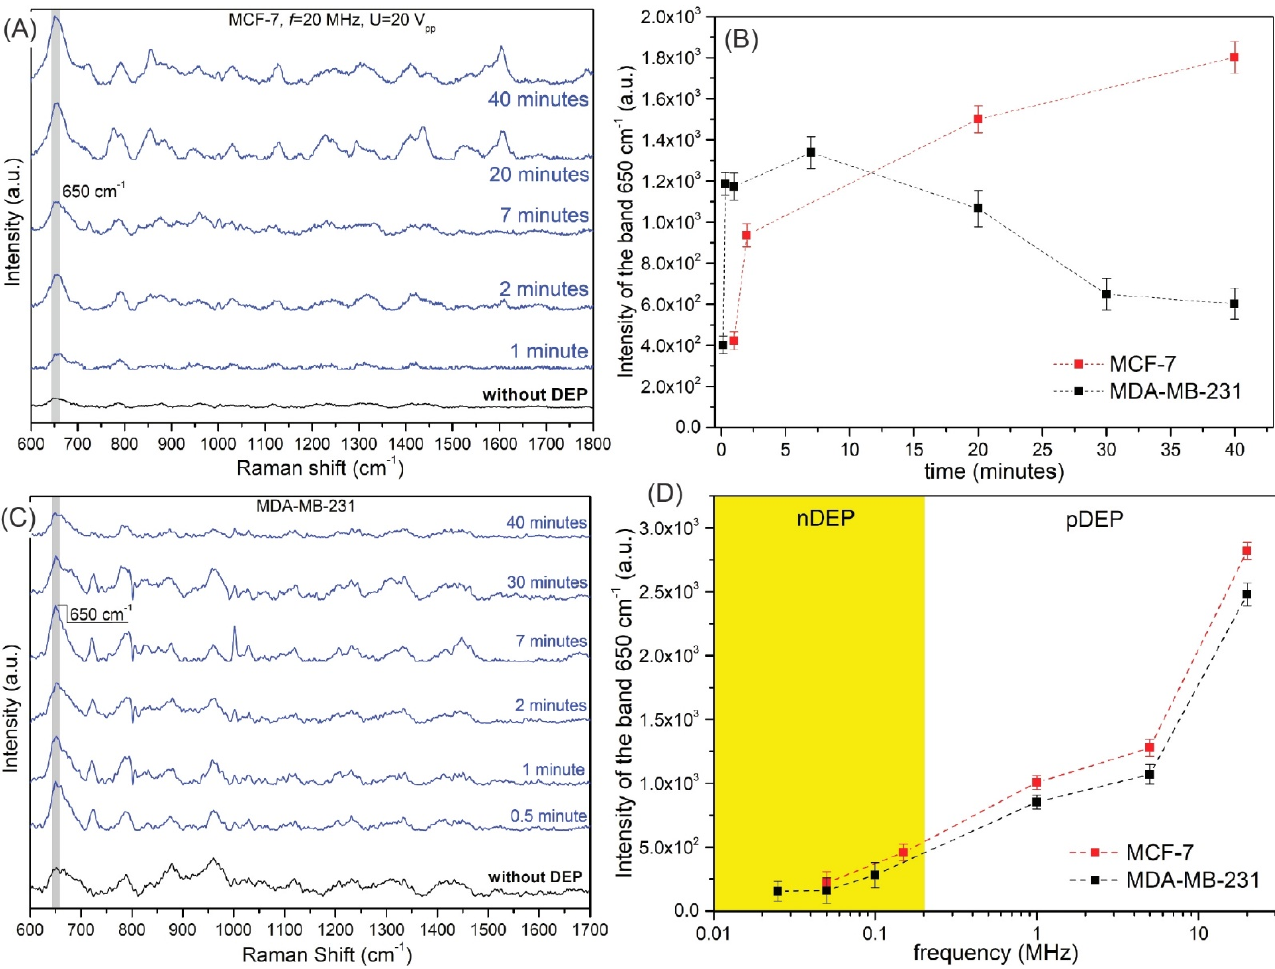
Figure 7. ( A ) The SERS spectra of the MCF − 7 cancer cells in the function of the deposition time via pDEP force for f = 20 MHz and U = 20 Vpp. ( B ) The averaged intensity of the band at 650 cm − 1 of the MCF − 7 ( f = 20 MHz, U = 20 Vpp) and MDA − MD − 231 ( f = 5 MHz, U = 20 Vpp) for different deposition times (0.5 min to 40 min). ( C ) The selected SERS spectra of the MDA − MB − 231 cancer cells in the function of the deposition time via pDEP force for f = 20 MHz and U = 20 Vpp. ( D ) The averaged intensity of the band at 650 cm − 1 of the MCF − 7 ( U = 20 Vpp, t = 20 min) and MDA − MD − 231 ( U = 20 Vpp, t = 7 min) for different applied frequencies. All measurements were performed in the 0.1 PBS